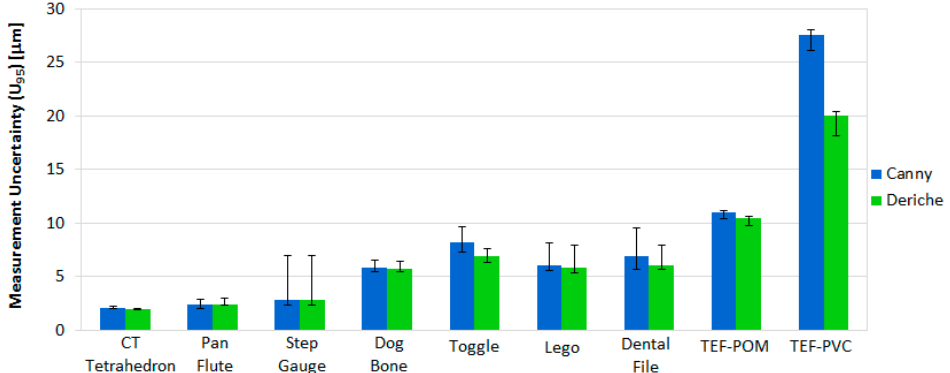
Figure 11. Expanded average measurement uncertainty ( U 95 ) for the Canny-based method (blue bars) and Deriche-based method (green bars), and maximum and minimum measurement uncertainties (error bars) of all the part dimensions for each item.